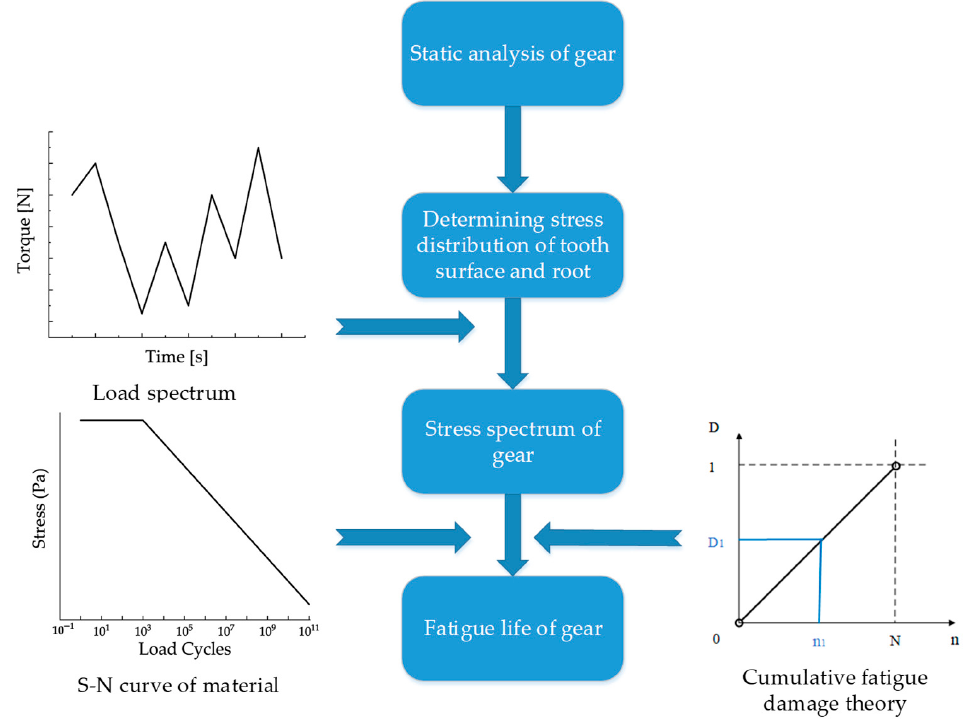
Figure 14. Fatigue life calculation process based on nominal stress method.